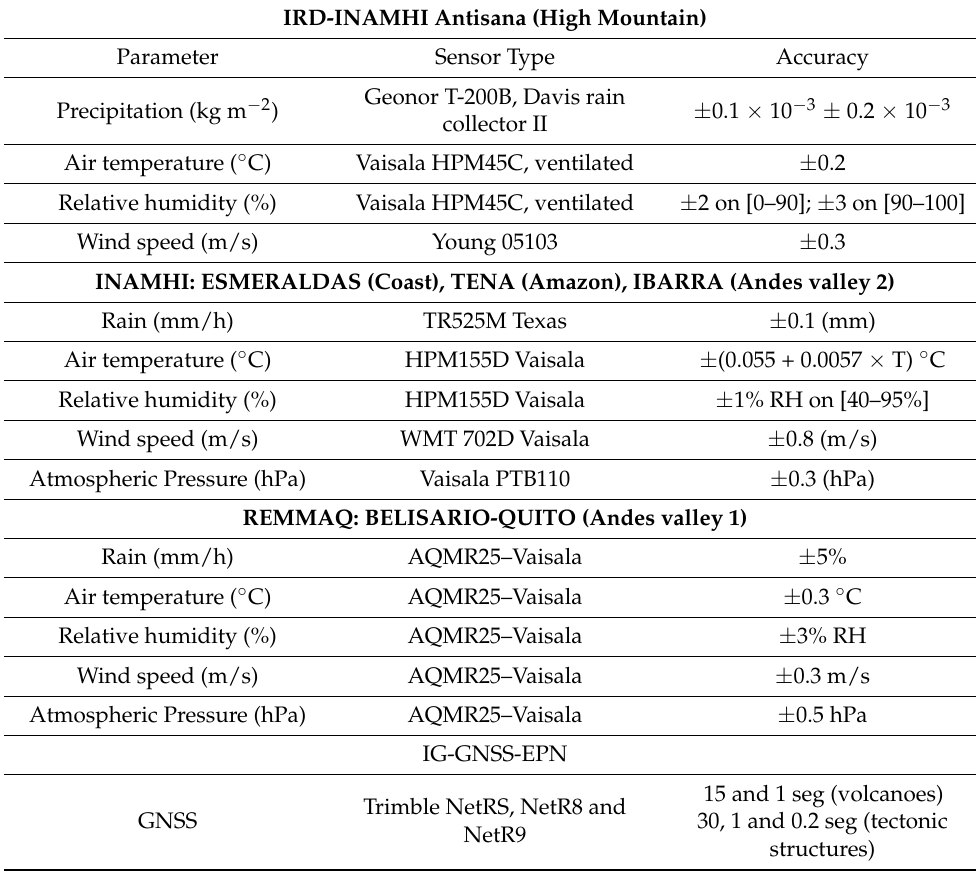
Table 2. Technical specifications of the weather and GNSS stations